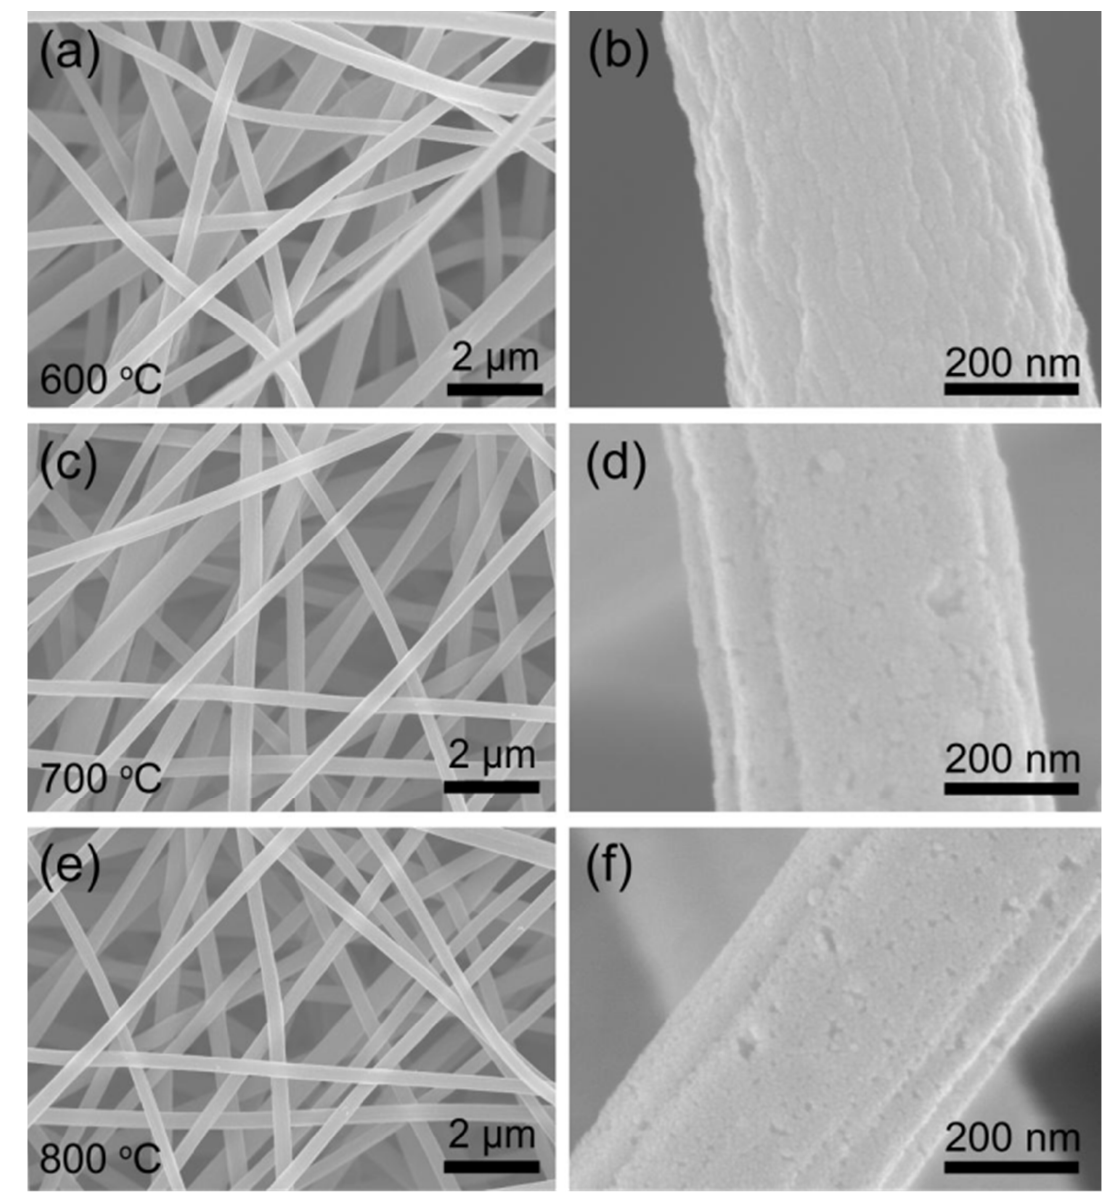
Figure 2. Low magnification and high magnification SEM images of heterogeneous submicron fibers loaded with binary metals and their compounds: ( a , b , 600 °C) CF-P 600, ( c , d , 700 °C) CF-P 700, ( e , f , 800 °C) CF-P 800.